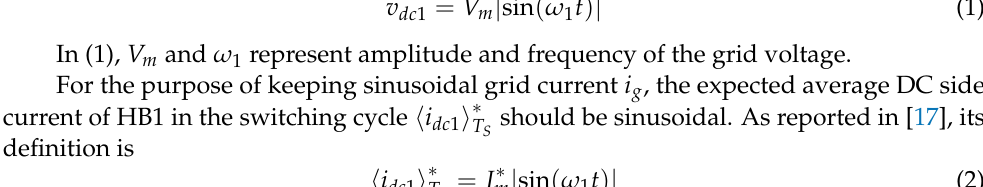
Figure 2. Switching period scale operating waveforms of ITPS. ( a ) k > 1, (cid:104) i dc 1 (cid:105) ∗ ( b ) k > 1, (cid:104) i dc 1 (cid:105) ∗